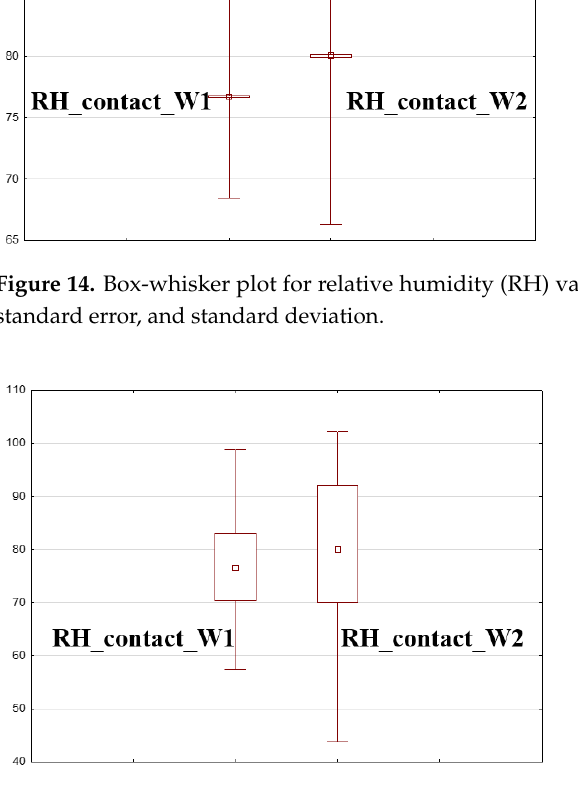
Figure 15. Box-whisker plot for RH values for the analyzed variants: median; 25–75%; Min-max.